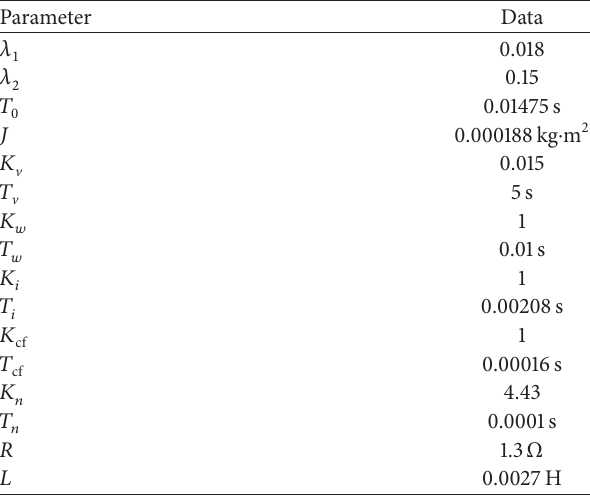
Table 1: Parameters